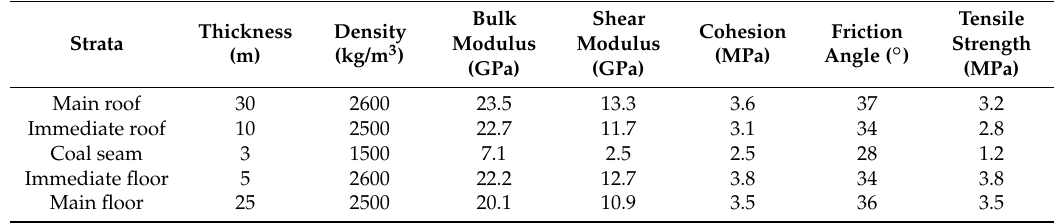
Table 2. Geology parameters of coal seam, roof, and floor strata.